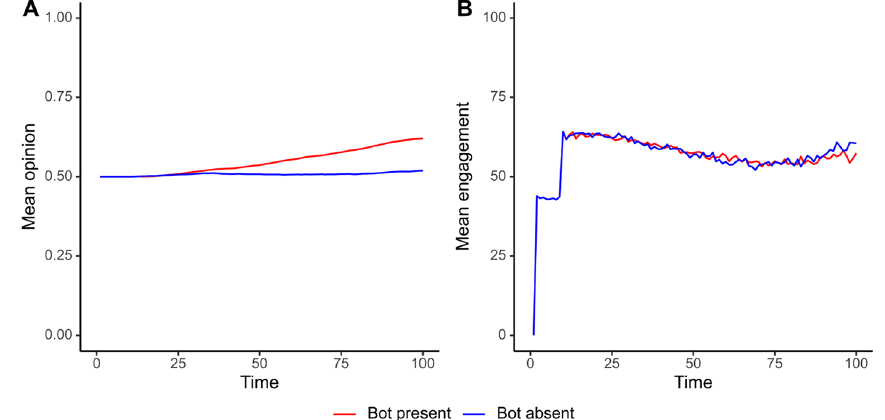
Fig. 2 Mean opinion and mean engagement in networks with and without bot influence. (a) Mean opinion of the agents over time. (b) Mean number of agents engaging with content in each timestep. Red: Treatment condition, the bot is part of the social network. Blue: Control condition, the bot is not part of the social network. A single bot can produce substantial changes in the mean opinion and mean engagement levels in the